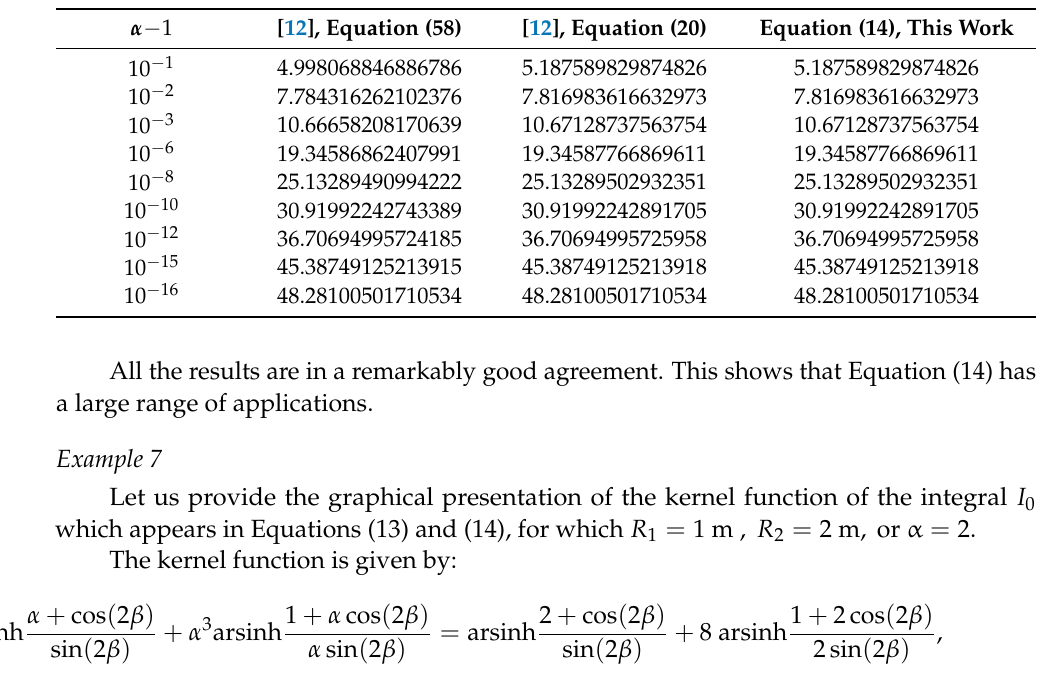
Table 4. Comparison of the results of Equation (14) with those from [12] (Equaition (58) and the